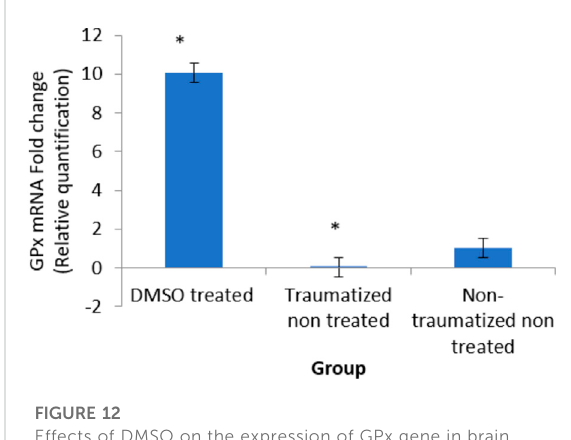
FIGURE 12 Effects of DMSO on the expression of GPx gene in brain cortex of TBI rats by relative quanti fi cation; DMSO- dimethylsulfoxide representing a treated group, TNT- Traumatized Non-Treated, NTNT – Non traumatized non- treated. Data are expressed as the mean ± S.D. n = 5 per group. Data analyses were conducted using a one-way analysis of variance (ANOVA). Post hoc analyses were performed using Tukey ’ s multiple comparison tests when appropriate. * p < 0.05 compared to the traumatized non- treated and non-traumatized non-treated